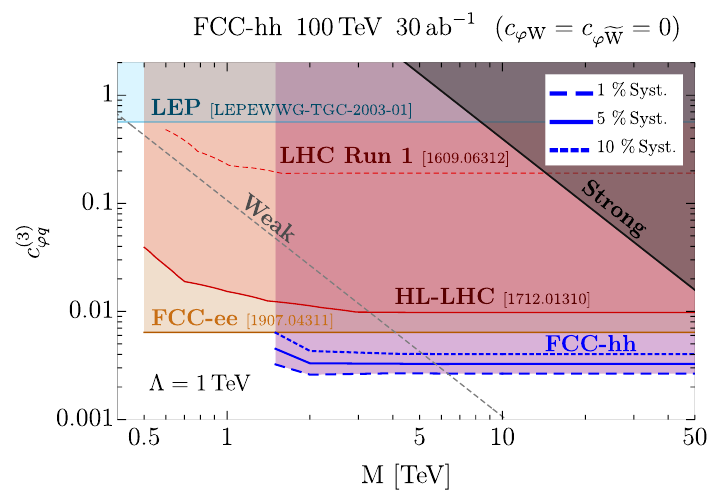
1 as a function (cid:0)